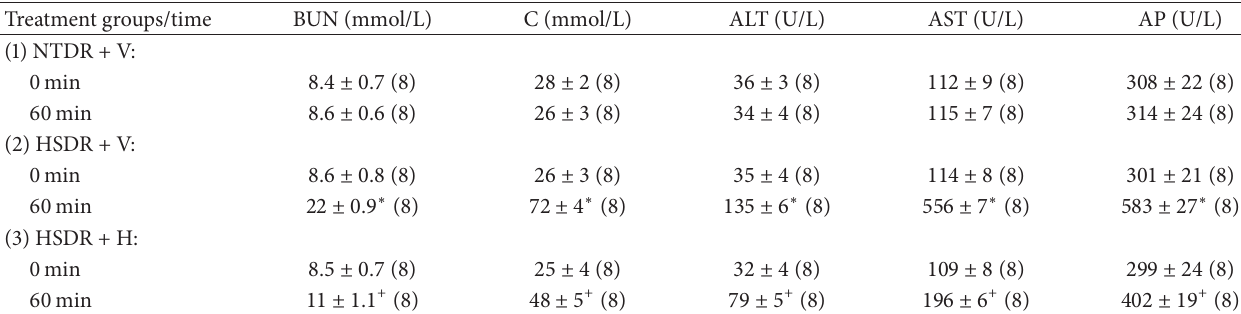
Table 4: The serum levels of blood urea nitrogen (BUN), creatinine (C), alanine aminotransferase (ALT), aspartate aminotransferase (AST) and alkaline phosphate (AP) for (NTDR + V) group, (HSDR + V) group, and (HSDR + H) group. Treatment groups/time